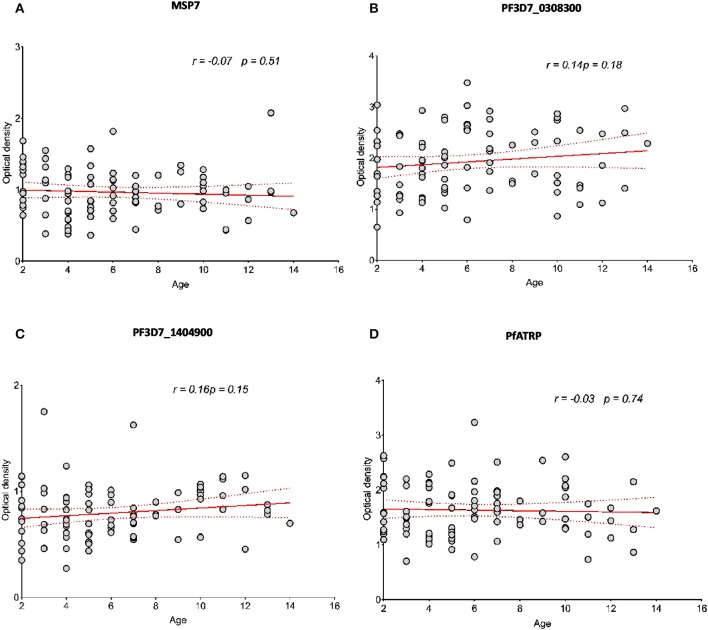
PfATRP human antibody response does not correlate significantly with age. (A–D) The scattered plots represents the pooled and age-matched data analysis for the antibody response patterns across the three malaria endemic sites for all antigens tested. The red lines depict the linear regression lines (plain lines) with their associated 95% confidence intervals (dotted lines). The Pearson correlation test was used to compute the coefficients of correlation between the measured variables. All statistical analyses were performed using GraphPad Prism v. 8.01.